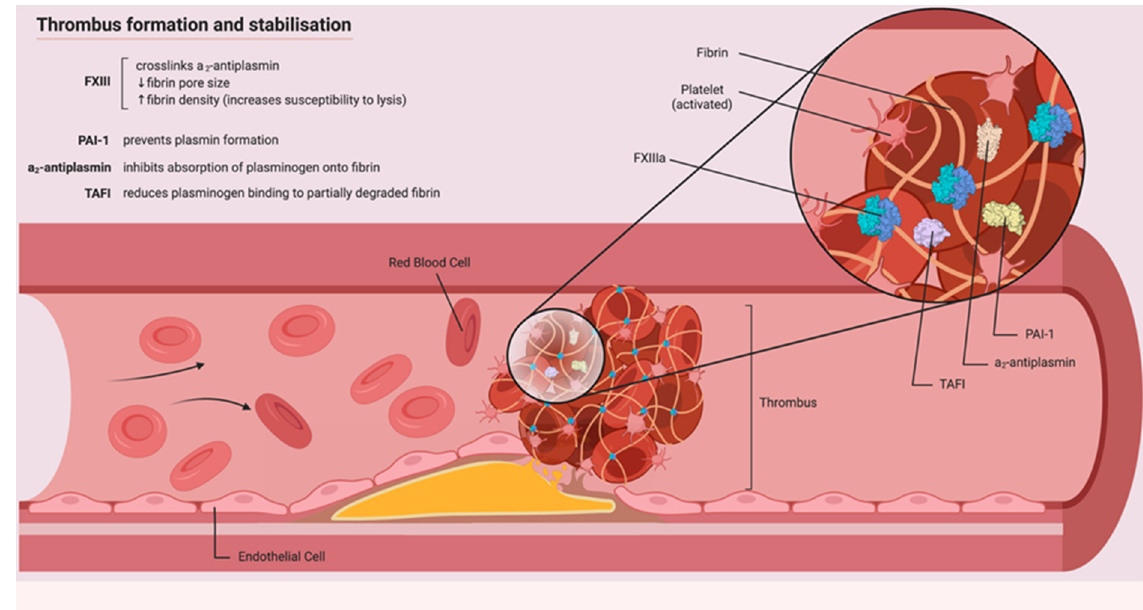
Figure 1. Thrombus formation and stabilisation: Coagulation factor XIII (FXIII) crosslinks fibrin fibers and stabilises the insoluble clot against dislodgement by high shear stress. It also decreases the size of the fibrin pores, reducing the ability of fibrinolytic molecules (such as tissue plasminogen activator (t-PA)) to diffuse within the clot. In addition, FXIII mediates the crosslinking of various antifibrinolytic proteins within the fibrin clot structure itself, further inhibiting clot dissolution. Major regulators of fibrinolysis include a2-antiplasmin (A2AP), thrombin-activatable fibrinolysis inhibitor (TAFI) and plasminogen activator inhibitor (PAI-1).